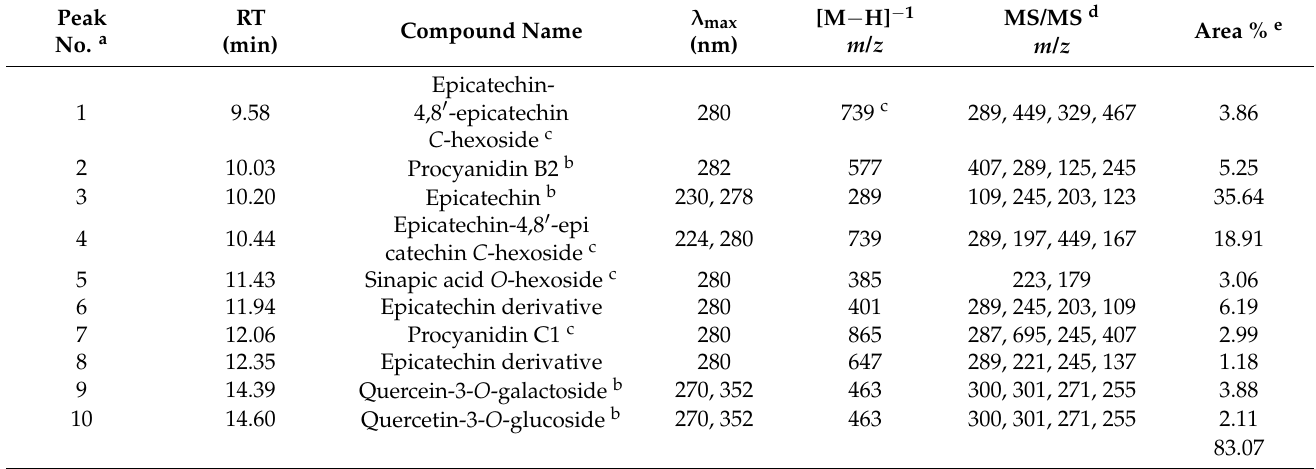
a Peaks numbers refer to Figure 2. b Compound identification by comparison with authentic standards. c Compound identification by comparison with the literature [11,36]. d MS/MS fragment ions are shown in decreasing order according to their signal intensity. e The calculations are based on considering the HPLC analysis detected at wavelengths of 210–600 nm on compounds existing in PEHE as 100%.